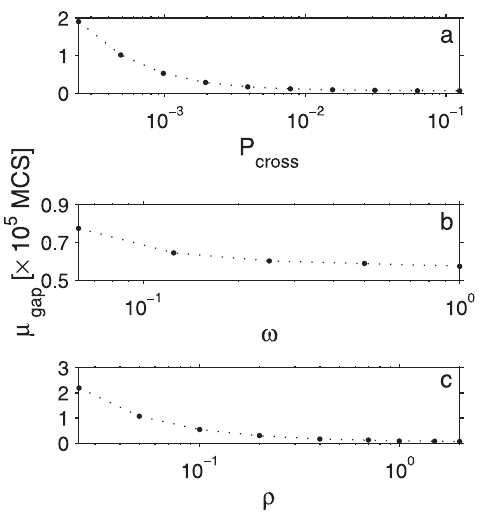
Figure 4. The mean gap duration, or the time between subsequent bursts, as a function of model parameters, obtained by Monte Carlo simulations. a. the effect of confine- ment strength on m gap . P cross varies between 2 { 12 and 2 { 3 . Other parameter values are: v ~ 1 , N ~ 200 , L ~ 20 a , t d im ~ 1 , r ~ 0 : 1 . In order to identify bursts, we considered t ~ 1 : 282 | 10 4 ,6 : 950 | 10 3 , 3 : 461 | 10 3 ,1 : 832 | 10 3 ,1 : 022 | 10 3 ,5 : 964 | 10 2 ,3 : 873 | 10 2 ,2 : 789 | 10 2 , 2 : 323 | 10 2 ,2 : 096 | 10 2 , for P cross ~ 2 { 12 ,2 { 11 , ::: ,2 { 3 , respectively. b. m gap plotted against v , with other parameters fixed at: P cross ~ 9 | 10 { 4 , N ~ 200 , L ~ 20 a , t dim ~ 1 , r ~ 0 : 1 . c. m gap as a function of density. Parameters were fixed at: v ~ 1 , N ~ 400 , L ~ 20 a , t dim ~ 1 , and r varies between 0.05 and 2 molecules per compartment. Error bars in all plots are smaller than the data points. In b and c , t ~ 3 : 912 | 10 3 simulation steps. on reaction kinetics. The effect of dimer lifetime, denoted by t dim , was found to be weak, and is only discussed in the Text S1 and demonstrated in Figure S2.